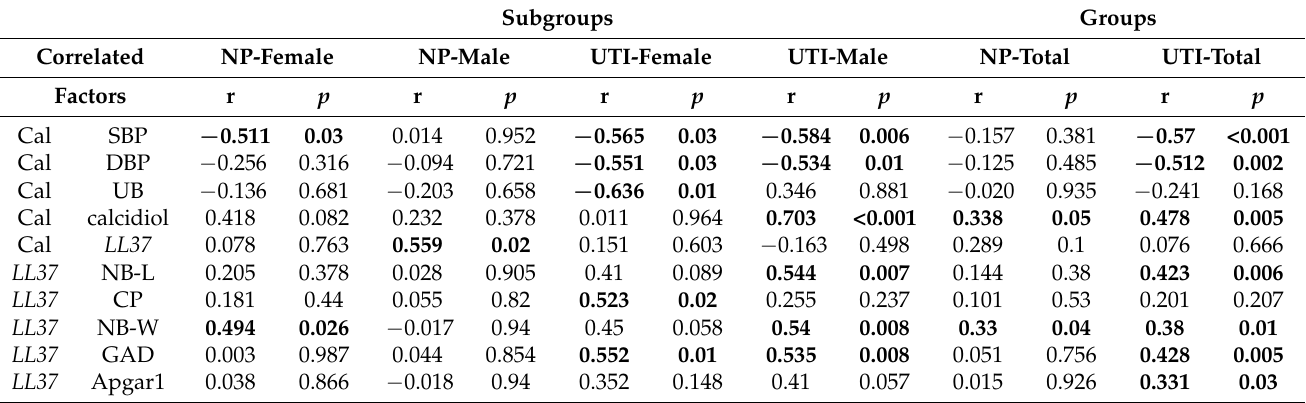
Table 2. Correlations between parameters with at least one significant